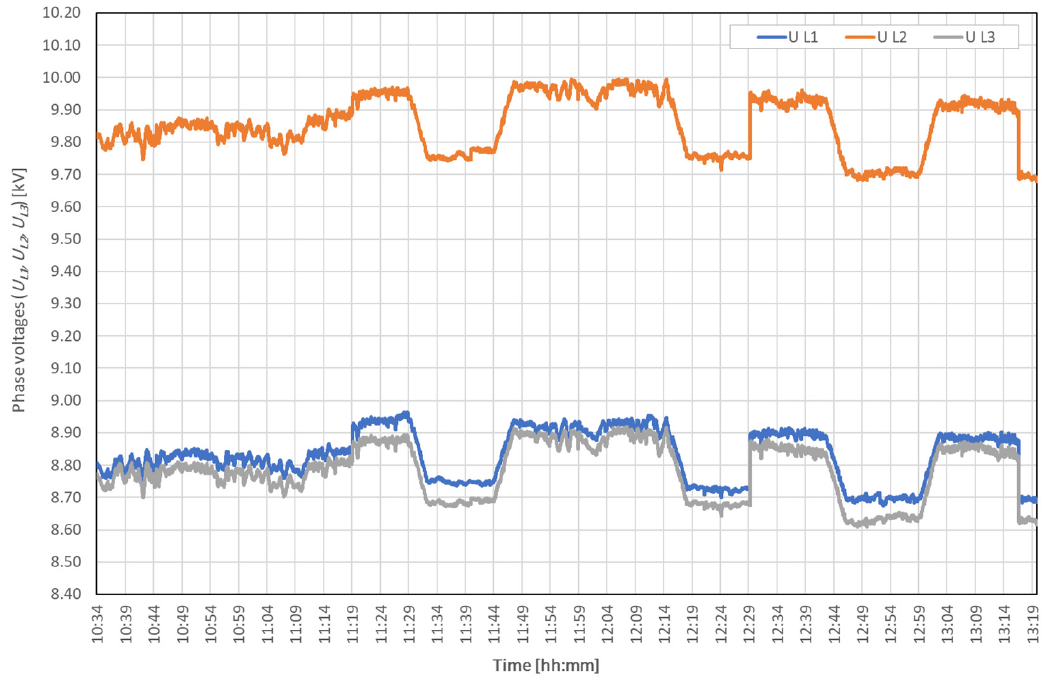
Figure 5. Time course of phase voltage values at the connection point of a wind power plant.